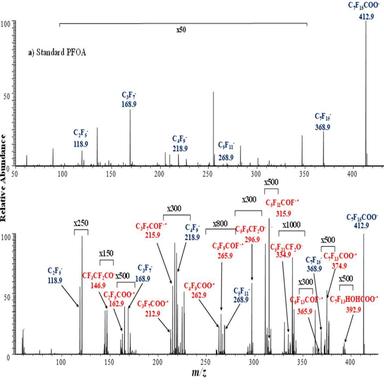
Negative ion mode MS spectra of 20 mg L− 1 of (a) standard PFOA and (b) electrochemically degraded PFOA.